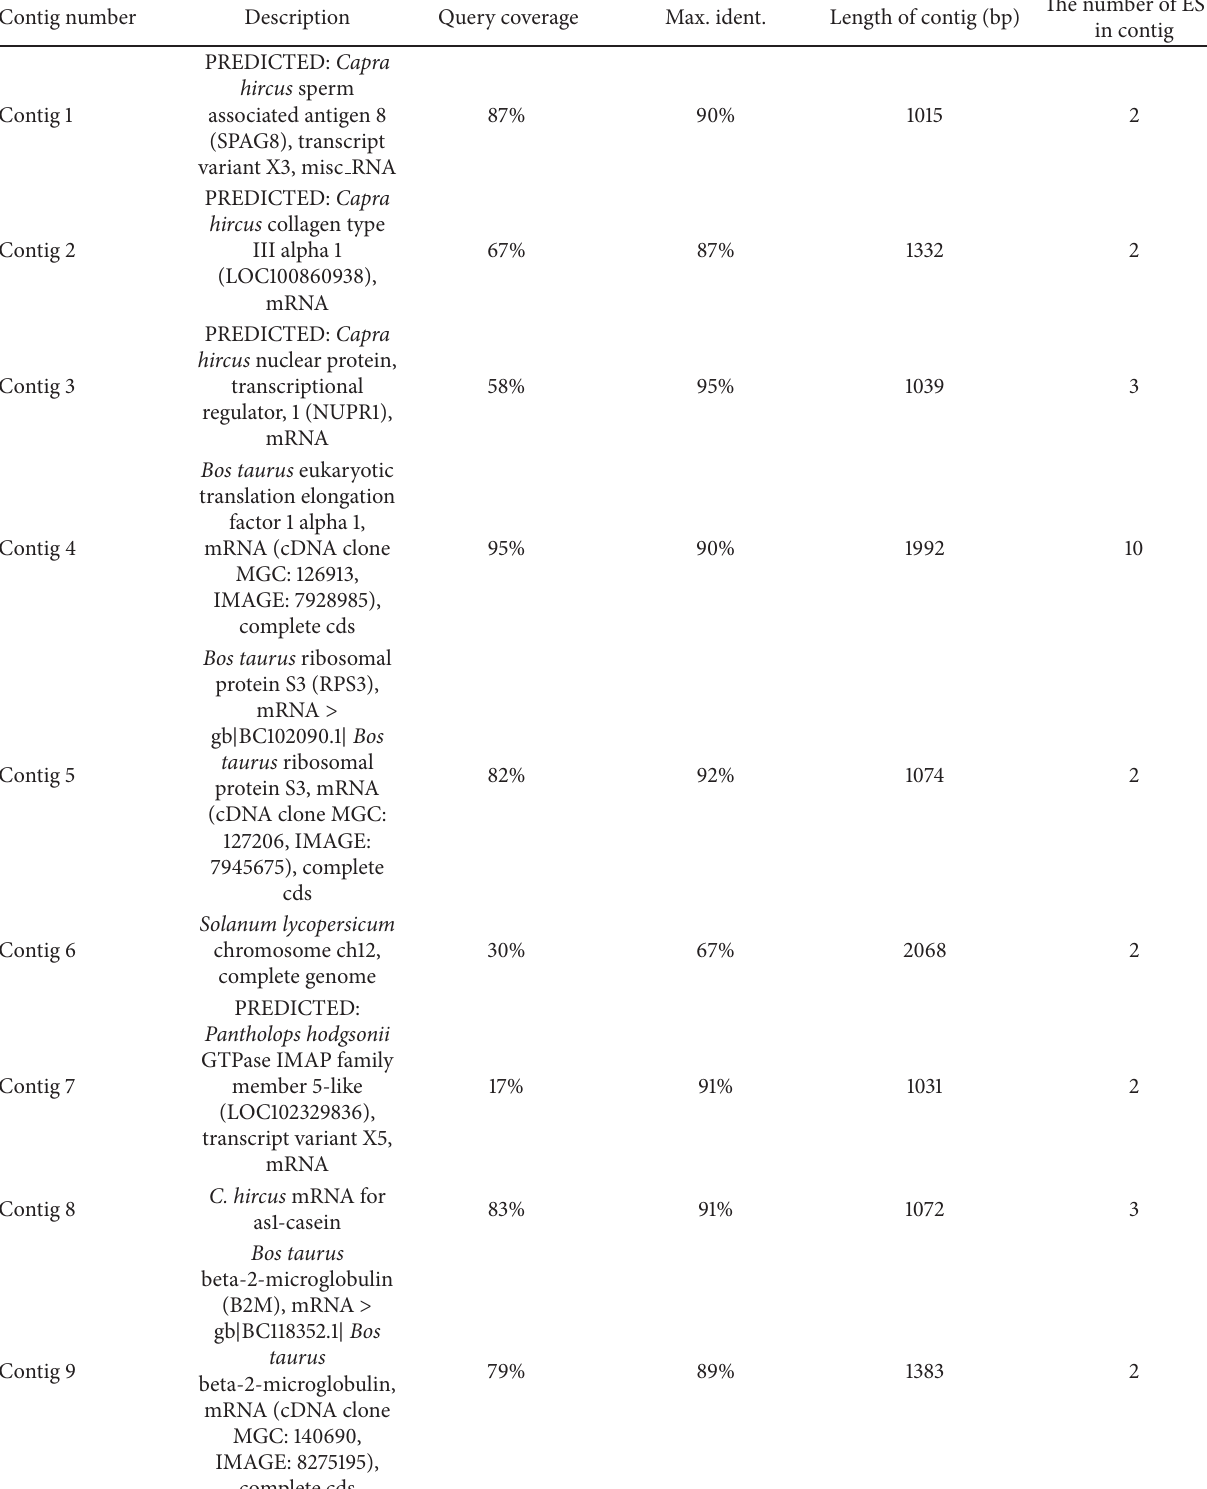
Table 4: The Blastn results of postnatal